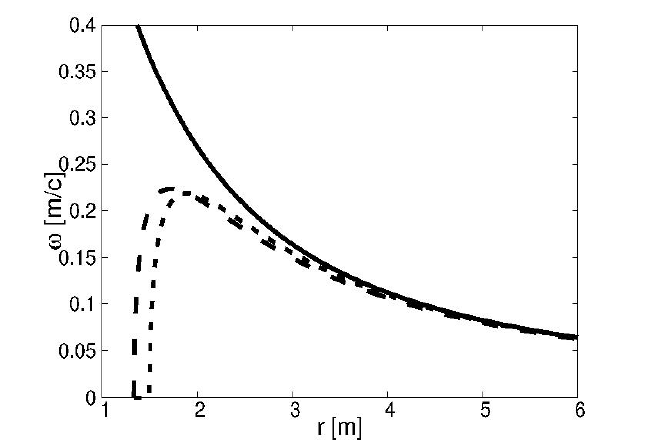
Figure 1. The dependence of the orbital frequency of a particle in a circular orbit on the radial distance. The upper curve shows the result for GR and the lower two curves for pc-GR. The one with its maximum further to the left corresponds to n = 3 and the other one to n = 4. Equation (21) was used for n = 3 and b = 81 for n = 4. with b = 64 27 8